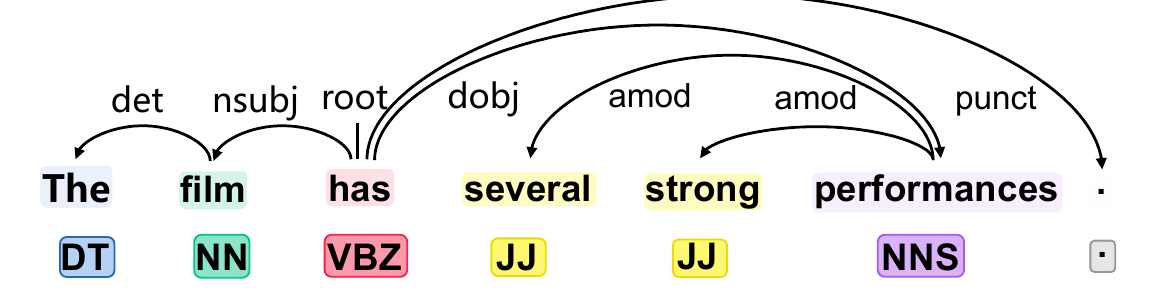
Figure 3. Directed graph of dependency analysis.